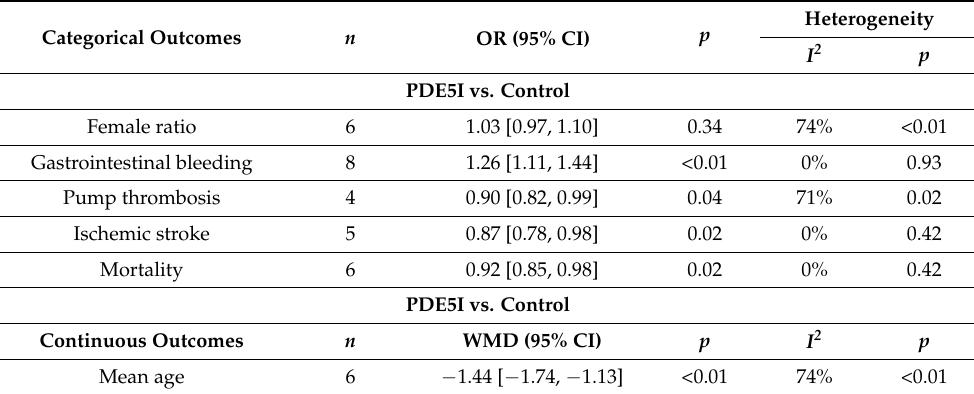
Table 2. Summary of the overall analysis of categorical and continuous outcomes.